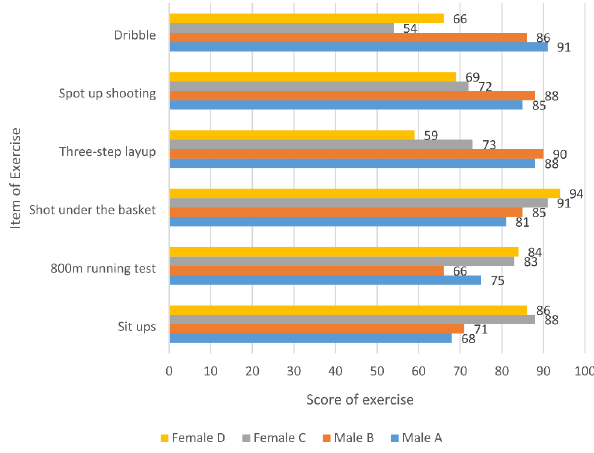
Fig. 6 Score chart of six basketball